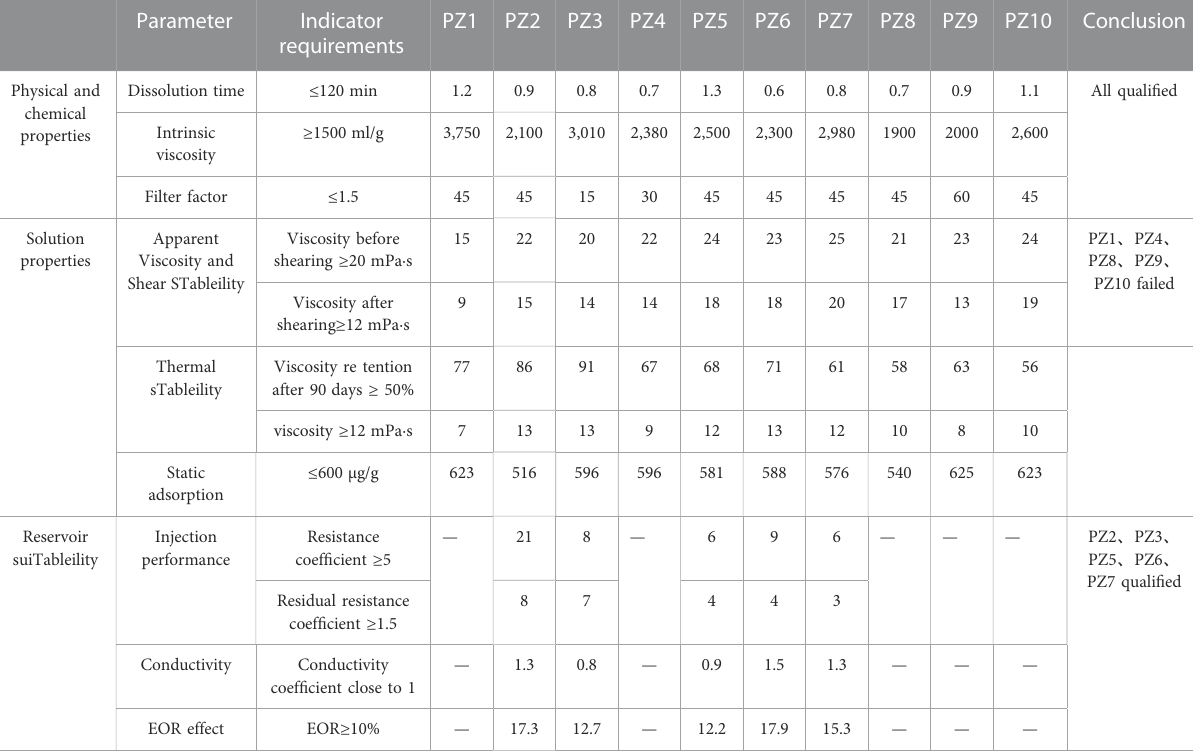
TABLE 3 Performance parameter evaluation results of 10